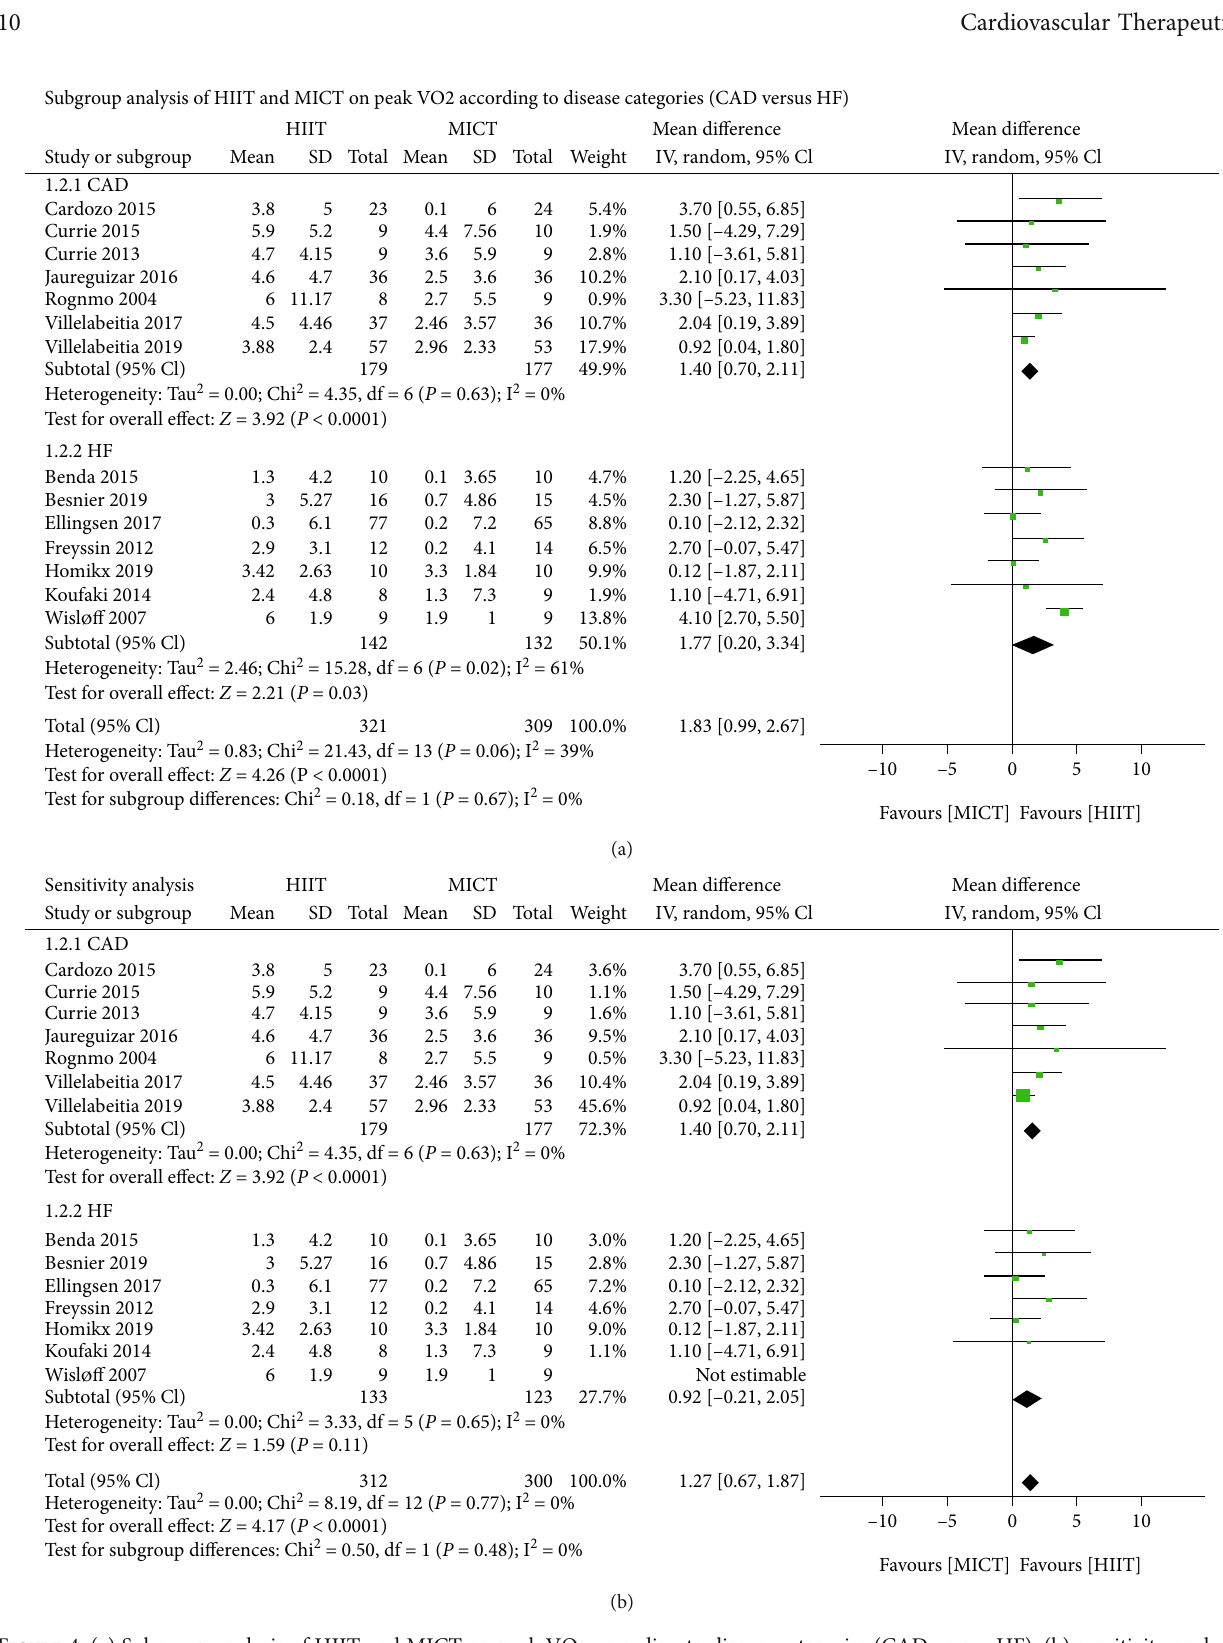
according to disease categories (CAD versus HF); (b) sensitivity analysis. 2 : peak oxygen consumption; CAD: coronary 2